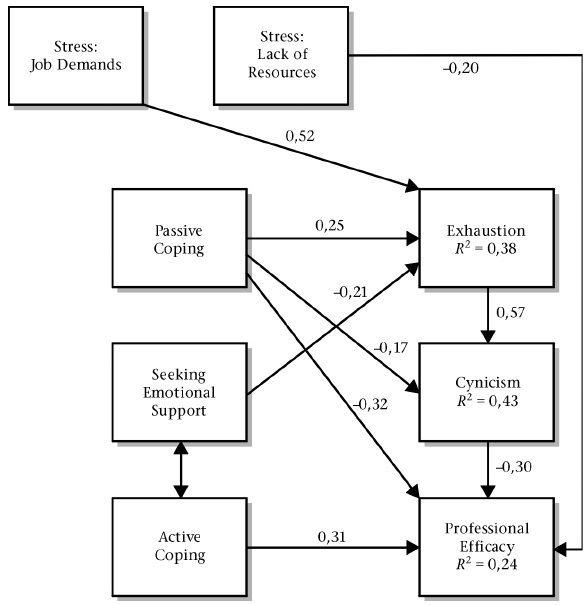
Figure 1: Model of